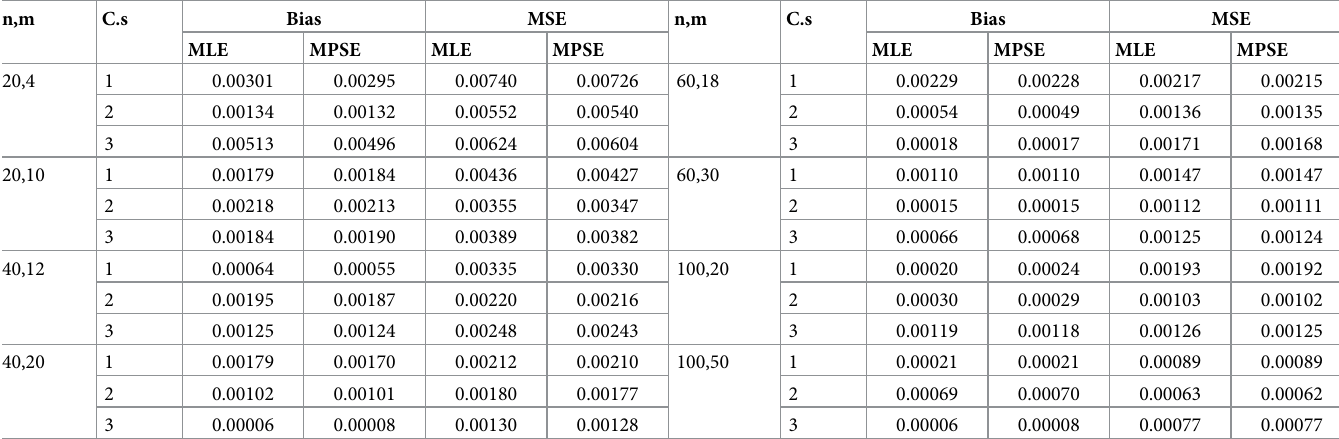
¼ X m for different censoring schemes when θ = 1 4